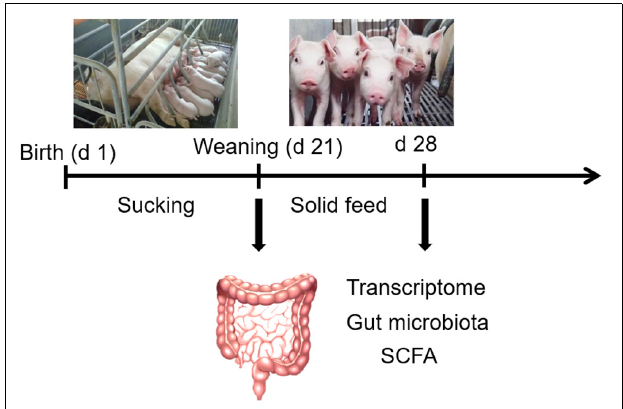
FIGURE 1 | The schematic diagram of experimental